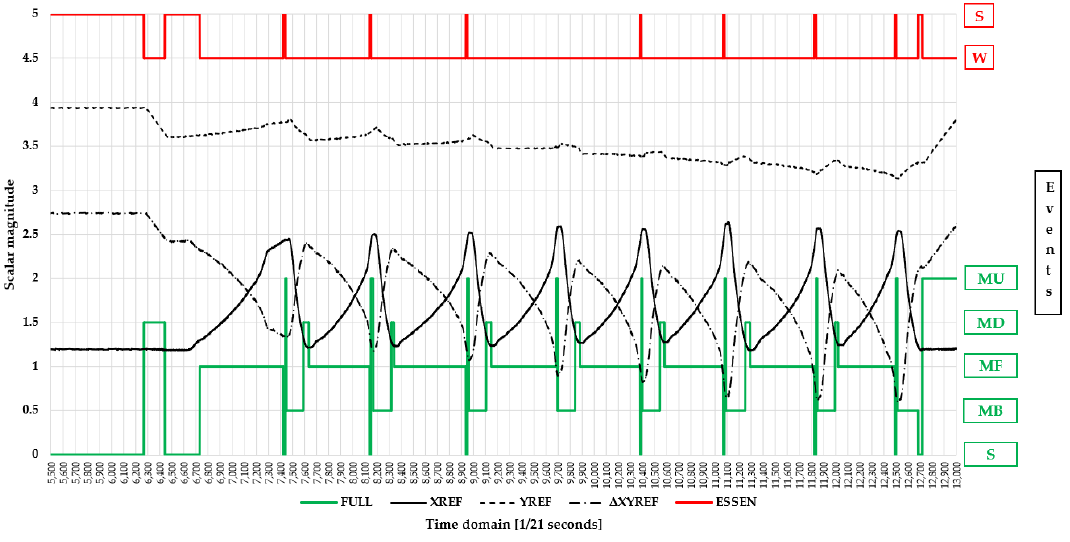
Figure 2. A partition of the original data extracted by tracking plotted against the coded events in the time domain. Legend: meaning of S , W , MU , MD , MF, and MB is given in Table 2, FULL —fully documented data, including the events S , MU , MD , MF and MB , ESSEN —essentially documented data, including the events S and W , meaning of X REF , Y REF , and ∆ XY REF is given in Table 1.